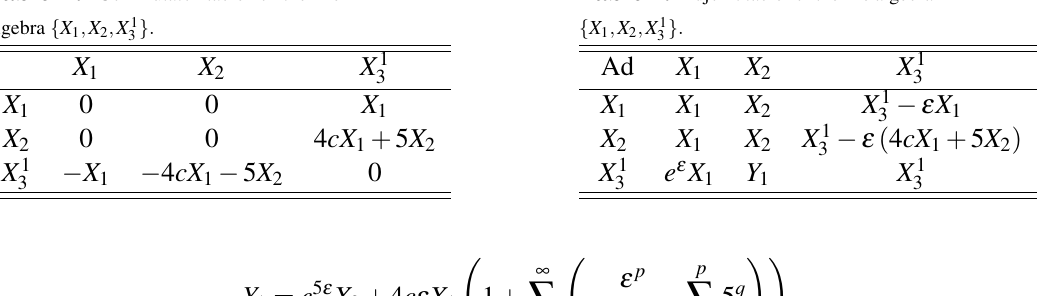
Table 2: Adjoint table for the Lie algebra { X 1 , X 2 , X 1 } . 3